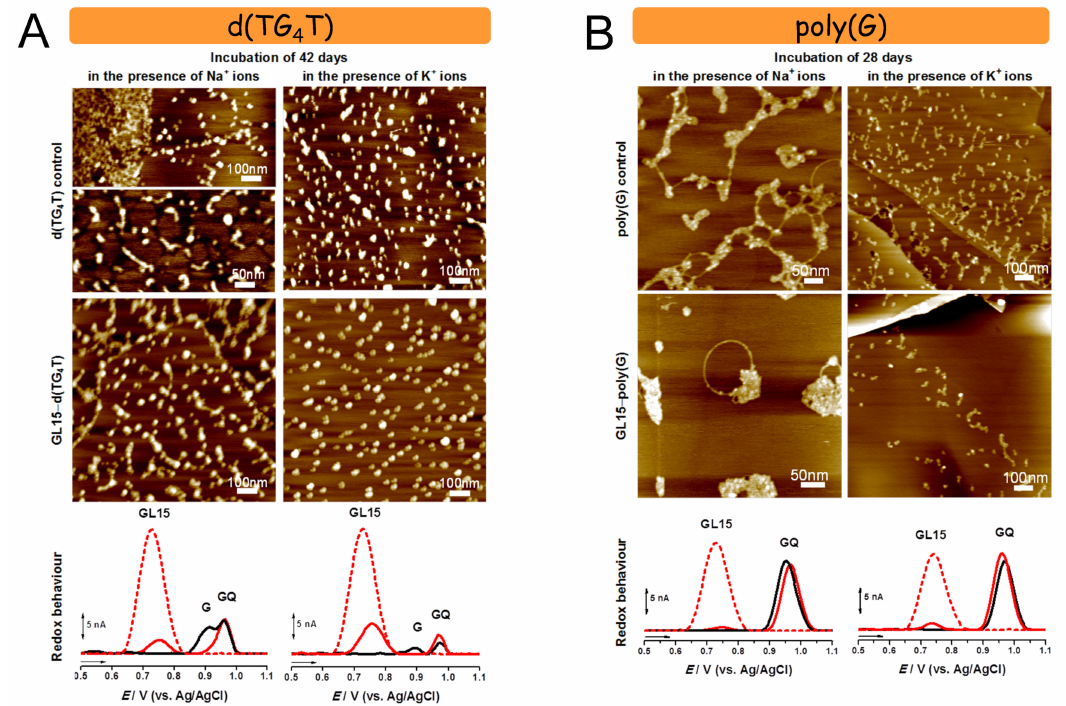
Figure 4. AFM images and baseline-corrected DPV of ( A ) d(TG4T) control and GL15-d(TG4T) and ( B ) poly(G) control and GL15-poly(G), in Na + and K + ion-containing solutions: (black line) DNA control, (red dotted line) GL15 control, and (red line) GL15-DNA. Adapted from [68] with